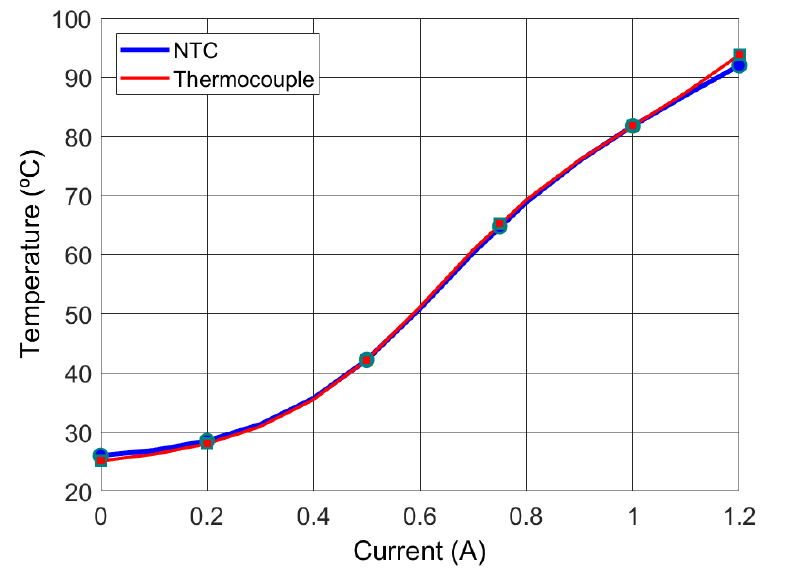
Figure 5. Temperature of both the agarose-TAE solution (thermocouple) and the NTC thermistor as a function of the